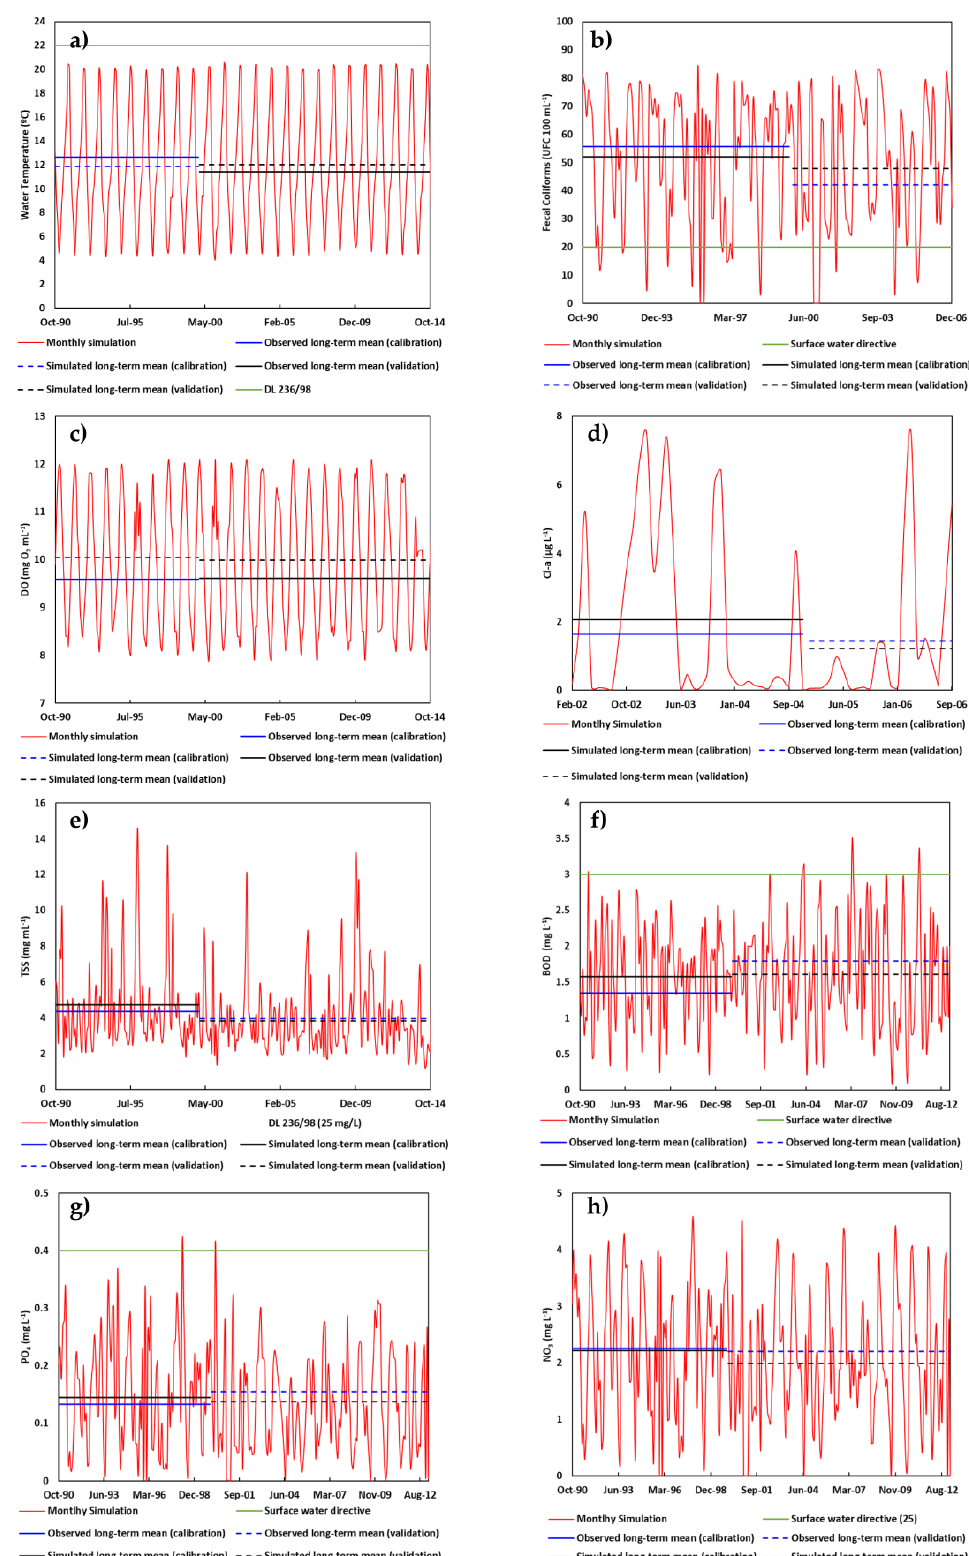
Figure 8. Monthly simulated (red line) and long-term means of observed (blue line) and simulated (black line) for the calibration and validation period (dashed lines) and maximum recommended value (MRV) of surface freshwater intended for the production of drinking water for type A1 treatment (green line) for ( a ) temperature, ( b ) faecal coliforms, ( c ) dissolved oxygen, ( d ) chlorophyll-a, ( e ) total suspended solids, ( f ) biochemical oxygen demand, ( g ) orthophosphates, and ( h )